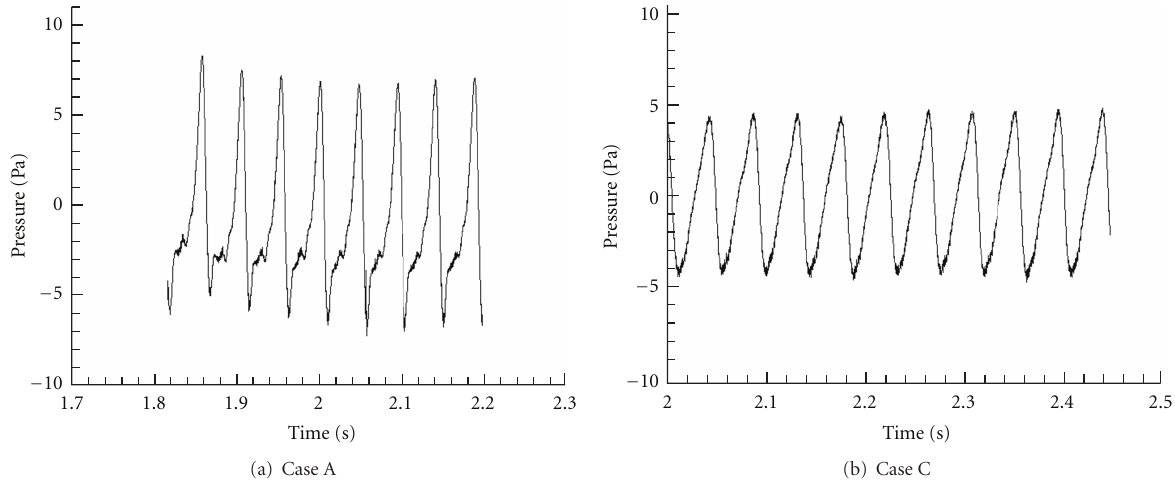
Figure 13: Time history of the pressure at a monitored point on the surface of the